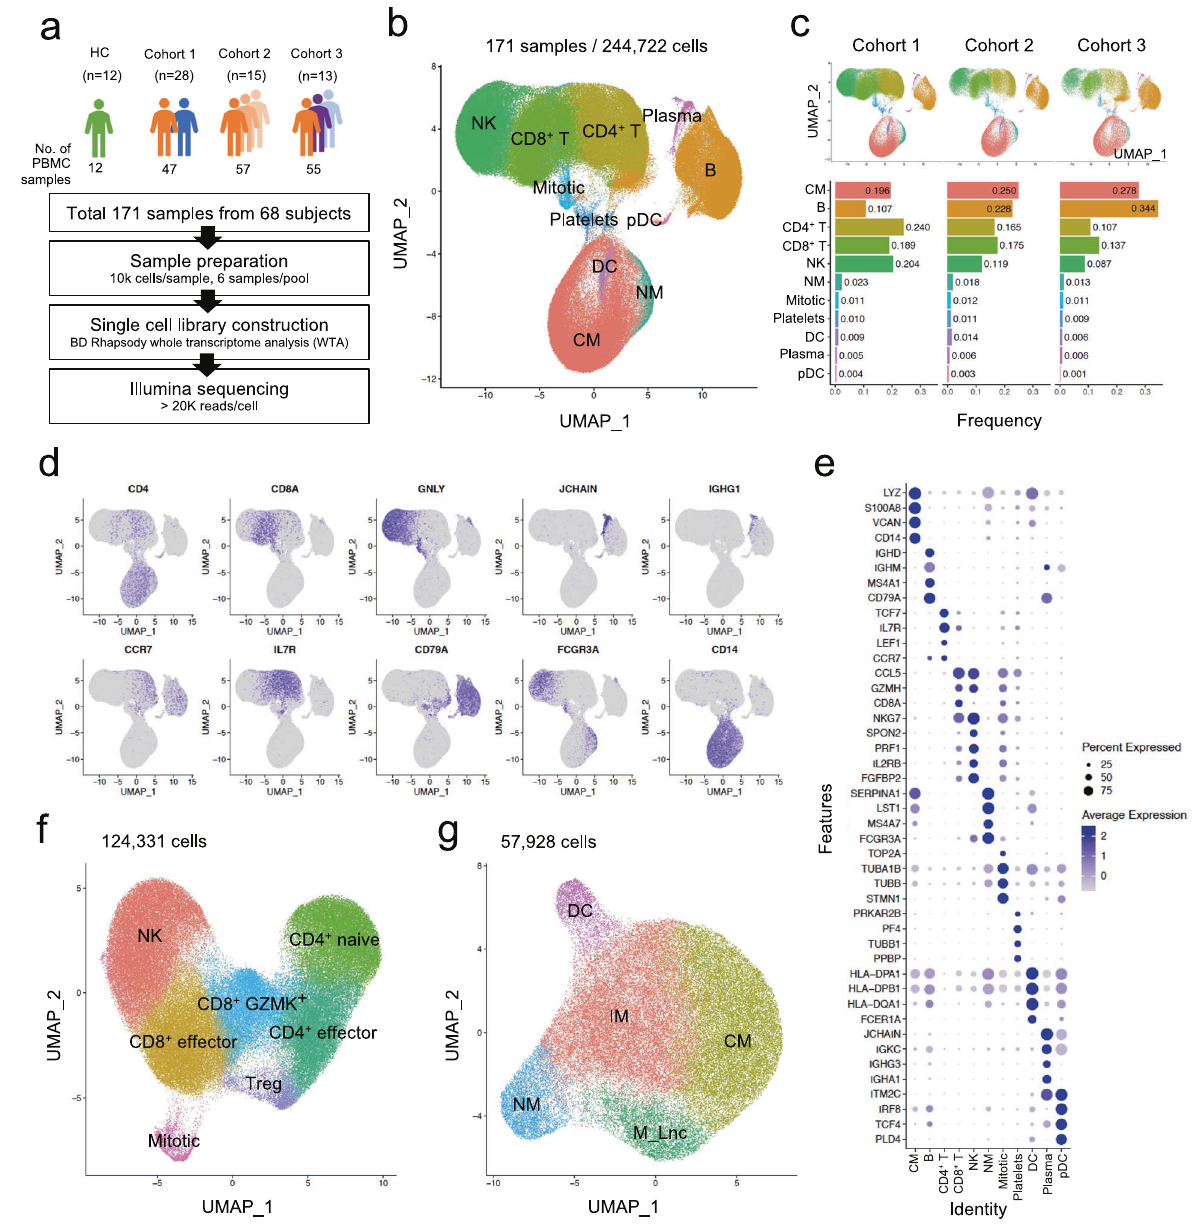
Fig. 1 Single-cell transcriptomics of PBMCs from COVID-19 patients. a Overall cohort design and analysis. b UMAP plot of PBMCs from all three cohorts. c Cell type frequency in each cohort. d UMAP plots depicting the expression of representative marker genes in each cell type. Colors represent the relative gene expression. e Dot plot showing the top four markers for each cell type. Dot size indicates the percentage of cells in which the gene was detected ( “ Percent Expressed ” ). Colors demonstrate the average expression level of the gene (scaled data) in each cluster ( “ Average Expression ” ). f UMAP plots showing subclusters of T- and NK-cell and ( g ) myeloid